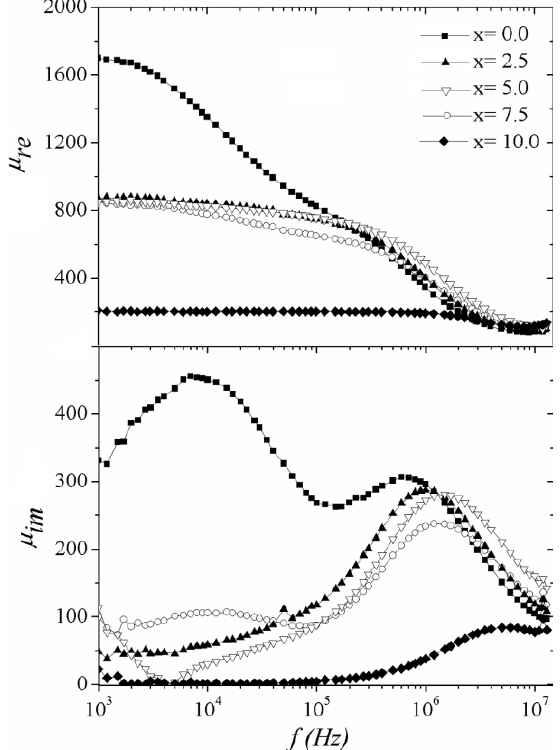
Figure 3. Spectroscopic plots of the complex permeability components for the